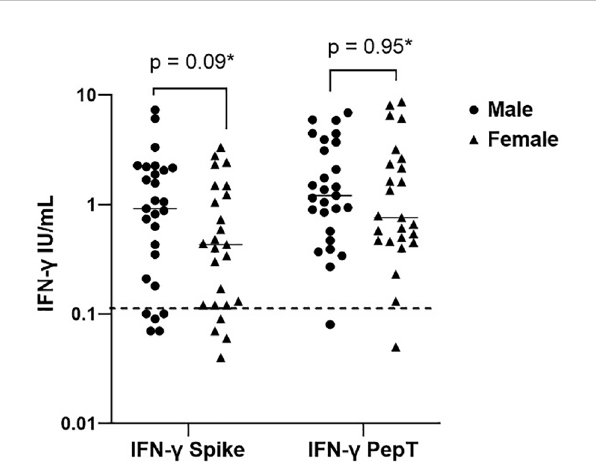
FIGURE 3 Sex differences in interferon-gamma production post primary vaccination to spike protein and peptide (S, S1, S+) mix stimulation. Individual values are plotted on a logarithmic scale (log 10). The dashed line represents the limit of the validated reference range (0.11IU/ml) and the solid line represents the mean for each group.*Mann-Whitney U